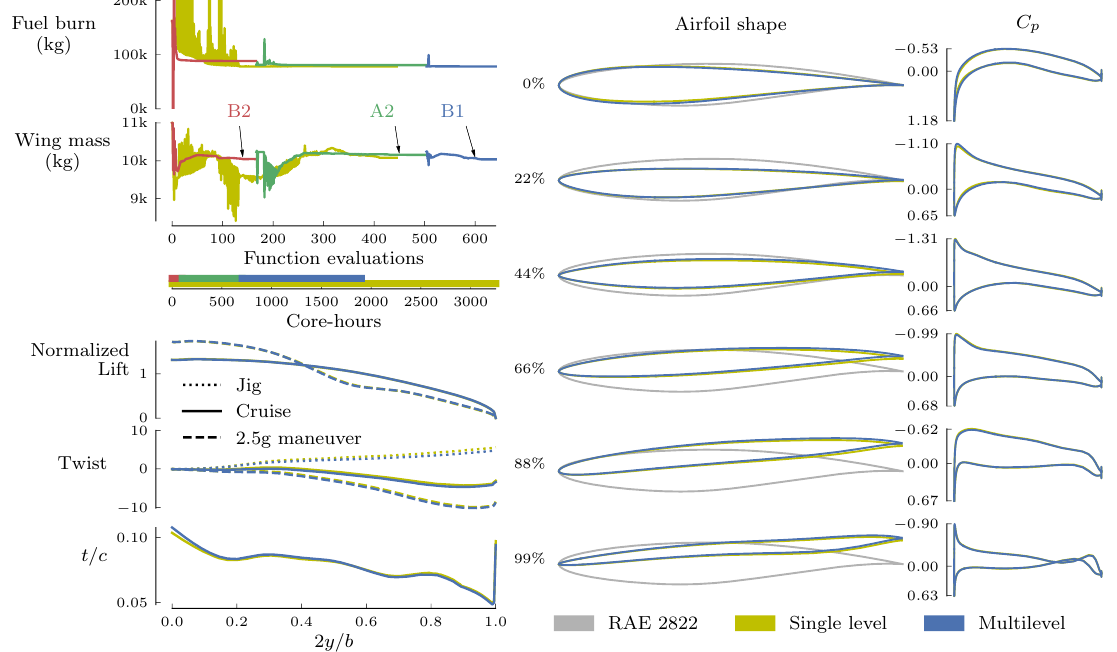
Figure 8. For this problem, the multi-level approach achieves essentially the same design as the single-level optimization with the finest mesh—at 60% of the computational